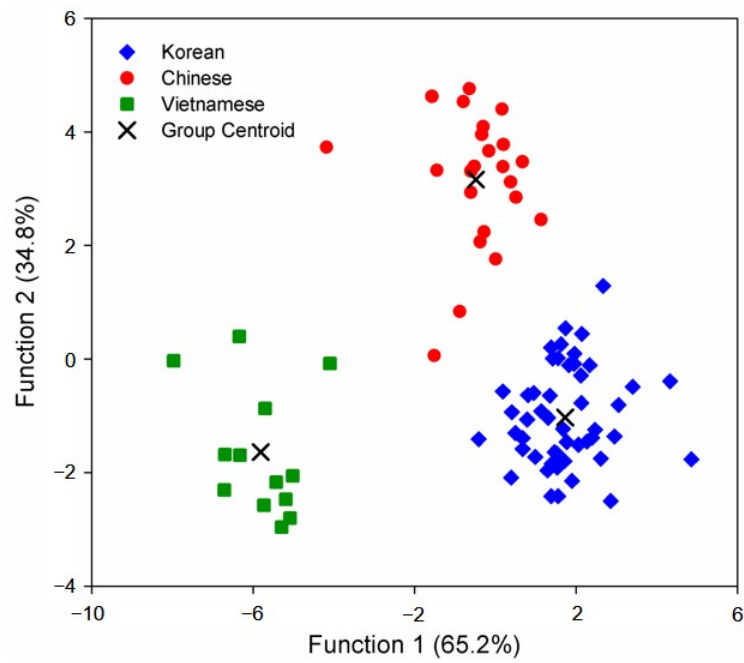
Figure 2. Scatter plot of two discriminant scores for the geographic origins of Korean, Chinese, and Vietnamese red pepper powders.